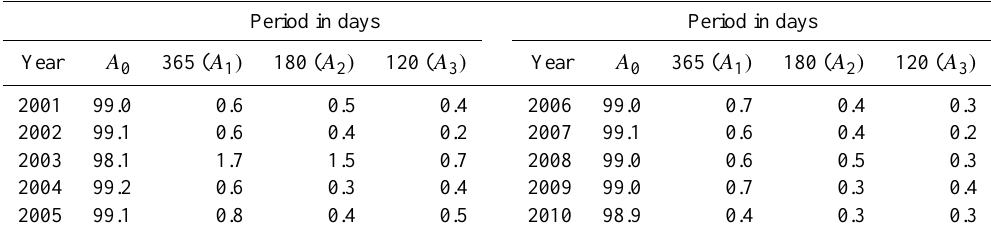
Table 3. Yearly area-averaged mean ratio r and amplitudes derived by Fourier analysis (values multiplied by 10 2 ) . Period in days Period in days